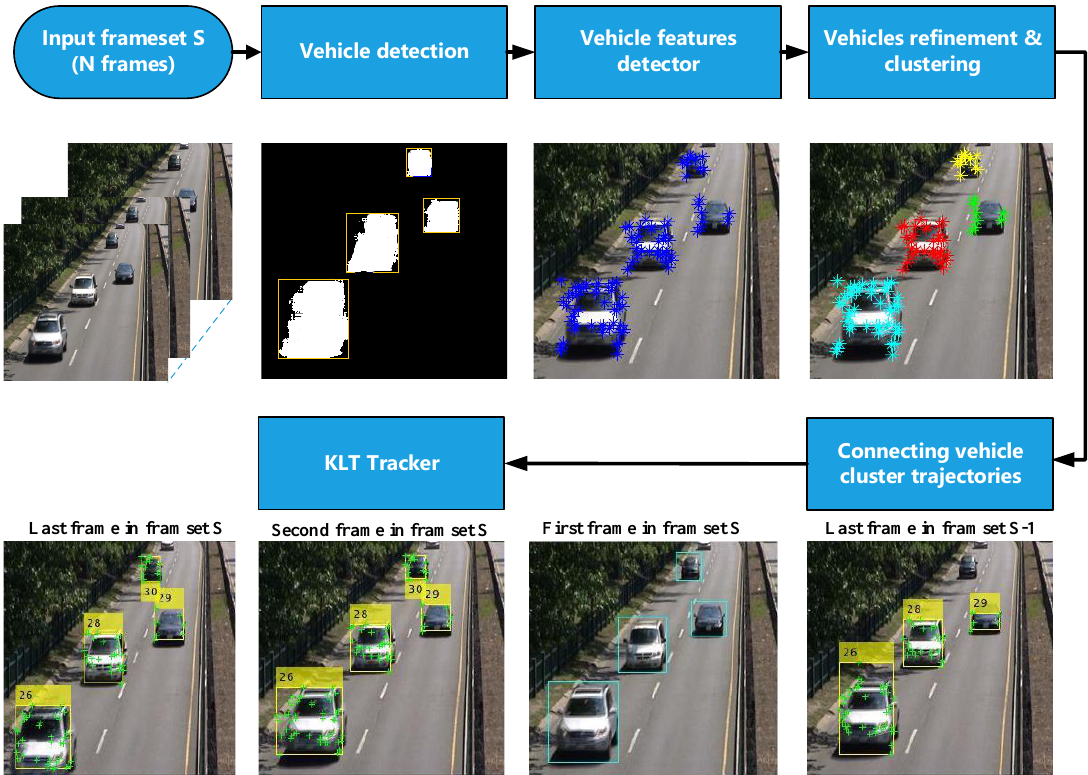
Figure 1. Block diagram of the proposed approach for a specific frameset S